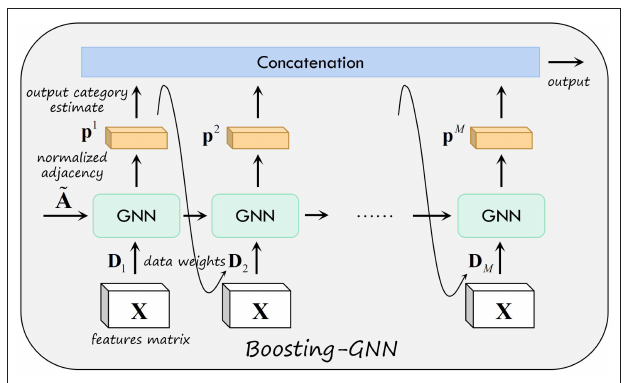
FIGURE 1 | Schematic of the proposed Boosting-GNN.